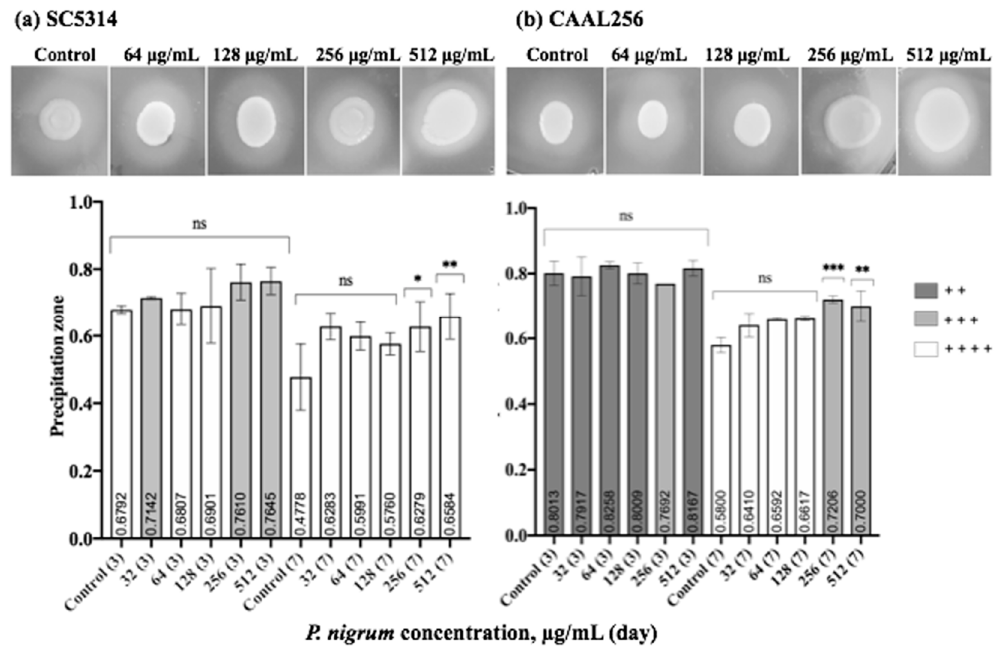
Figure 6. Phospholipase production by C. albicans ( a ) SC5314 and ( b ) CAAL256 strains. Control bars indicate untreated cells for 3 and 7 days. Pz classification: 1.0 ( − ) indicates that the tested strain was negative for phospholipase production: 0.99–0.90 (+) very low; 0.89–0.80 (+ +) low; 0.79–0.70 (+ + +) moderate producers; and Pz ≤ 0.69 (+ + + +) high producers. p -values of <0.05 were used to indicate statistical significance as follows: * p ≤ 0.05. ** p ≤ 0.01. *** p ≤ 0.001. ns: Not significant.